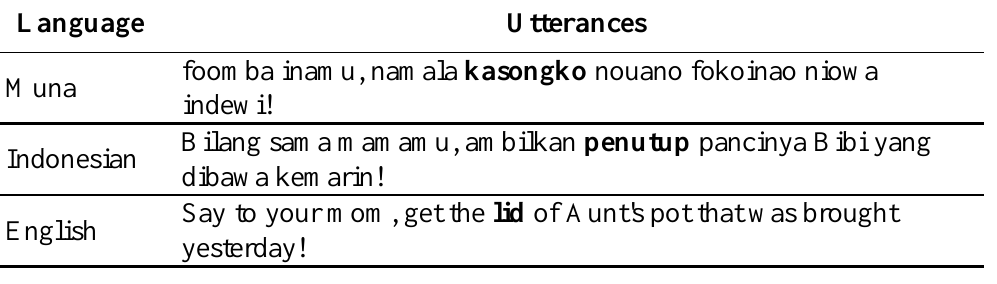
The correct word form of katutup Utterances